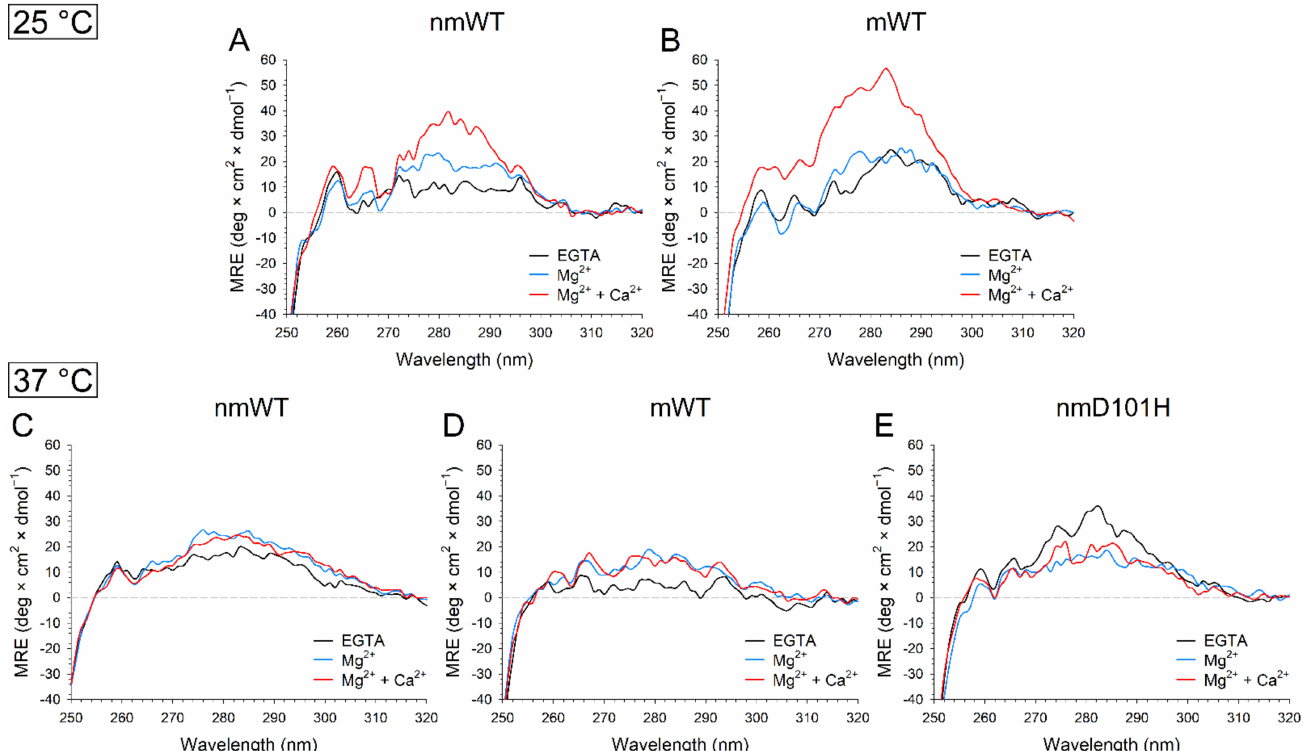
Figure 7. Representative near UV CD spectra recorded at 25 ◦ C of ~30 µ M ( A ) nmWT; and ( B ) mWT GCAP3 in the presence of 500 µ M EGTA (black) and after sequential additions of 1 mM Mg 2+ (blue) and 1 mM Ca 2+ (red), leading to approximately 500 µ M free Ca 2+ . Representative far UV CD spectra recorded at 37 ◦ C of ~8 µ M ( C ) nmWT; ( D ) mWT; and ( E ) nmD101H GCAP3 in the same